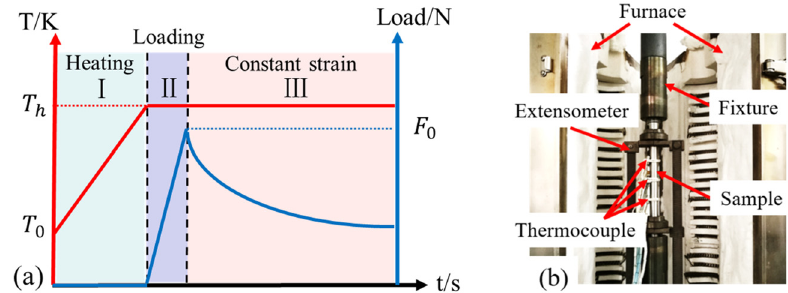
Figure 3: ( a ) Schematic of stress relaxation test procedures; ( b ) stress relaxation testing